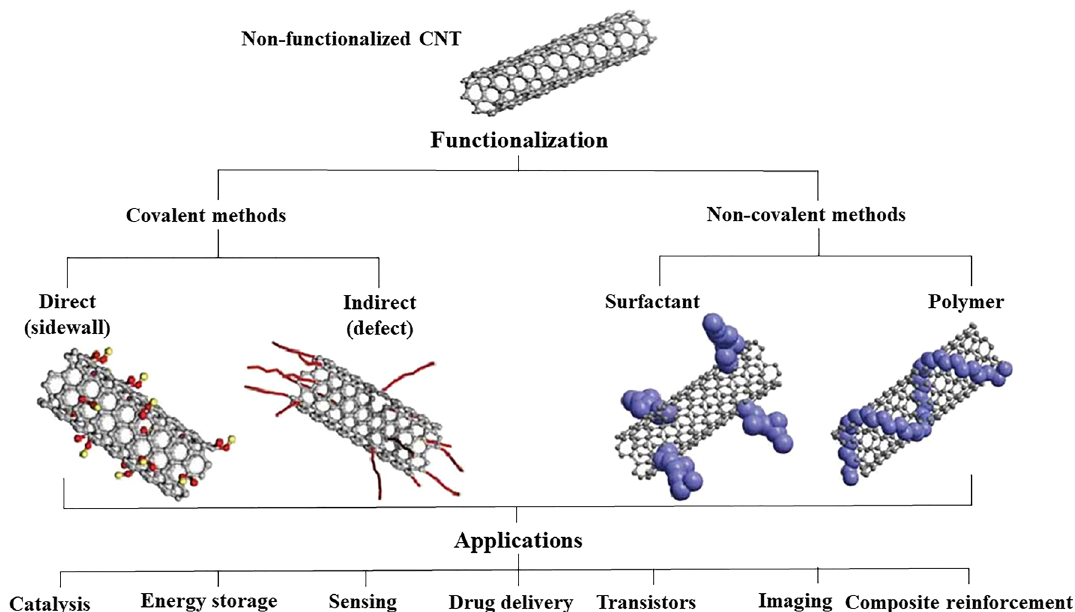
Fig. 1 Functionalization methods and applications of carbon